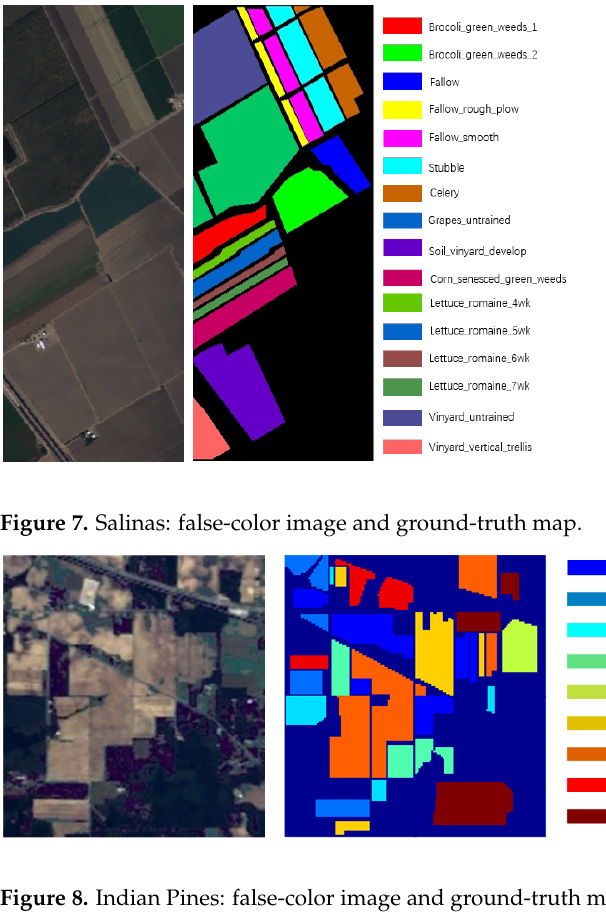
Figure 8. Indian Pines: false-color image and ground-truth